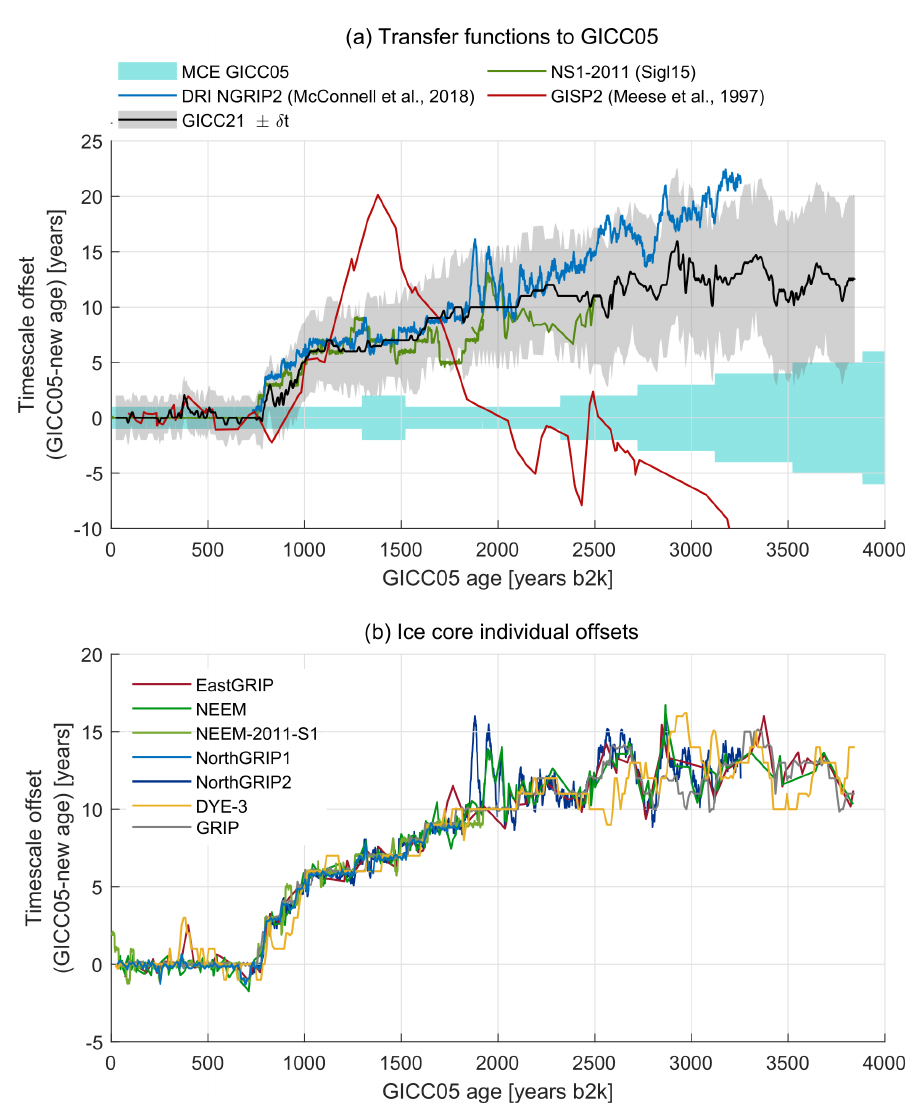
Figure 4. Timescale comparison. (a) Published timescales and GICC21 compared to GICC05. The shaded areas highlight the uncertainty of both GICC05 (light blue) and GICC21 (gray). The GISP2 timescale was compared using the published match with GICC05 (Seierstad et al., 2014); it agrees with GICC05 at the former Vesuvius tie point, but we observe how it also agrees with the recent revisions until the 1109b2k eruption, before it spreads to wider offsets. The NS1-2011 timescale (Sigl et al., 2015) agrees with our revision within uncertainties as well as with the DRI_NGRIP2 timescale (McConnell et al., 2018). (b) The individual ice cores have different offsets from GICC05 depending both on the volcanic match and on the layer counting differences. A direct comparison with GICC05 is possible for the ice cores NorthGRIP, GRIP, and DYE-3, for which both GICC05 and GICC21 are annual-layer-counted. The NorthGRIP1 layer comparison stops at 1813b2k, corresponding to the end of the IC dataset, but the NorthGRIP2 comparison continues thanks to the DRI CFA dataset. An indirect comparison was possible for EastGRIP and NEEM, for which published match-point ages were used to interpolate to the new layer-counted ages (Rasmussen et al., 2013a; Mojtabavi et al., 2020a). The comparison for NEEM-2011-S1 was possible using the matching of the ice core onto GICC05 using the tie points provided in Sigl et al.